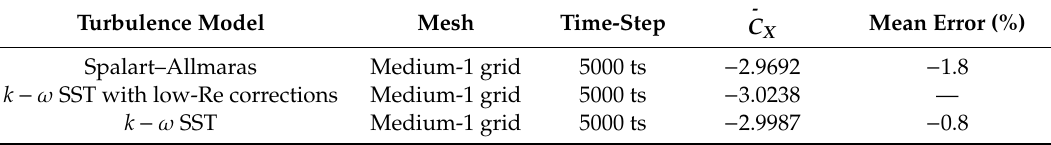
Table A1. Comparison of results from three turbulence models for semi-active flapping foil. Turbulence